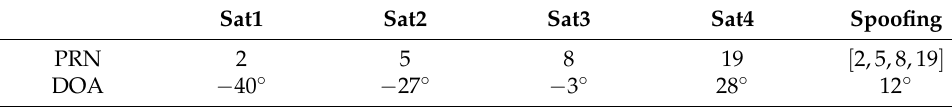
Table 4. Simulation parameters of incident sources in Section